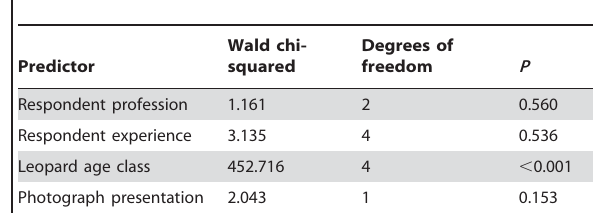
Table 1. Results of generalized linear models assessing the likelihood of survey respondents correctly identifying the